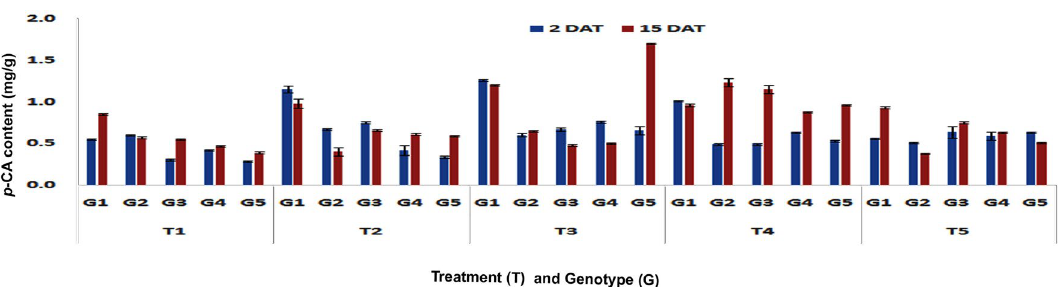
Figure 4. Changes in p -CA content in stalk tissues of maize genotypes to induced treatments in short (2 DAT) and long (15 DAT) term responses on the imposition of treatments at V6 stage (G1: DMRE 63; G2: CM